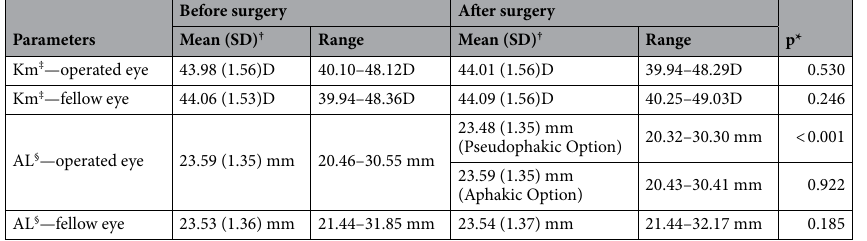
Table 1. Mean keratometry and axial length values before and after the cataract surgery. † Standard deviation; *p value obtained by paired T-test; ‡ mean Keratometry, § axial length.